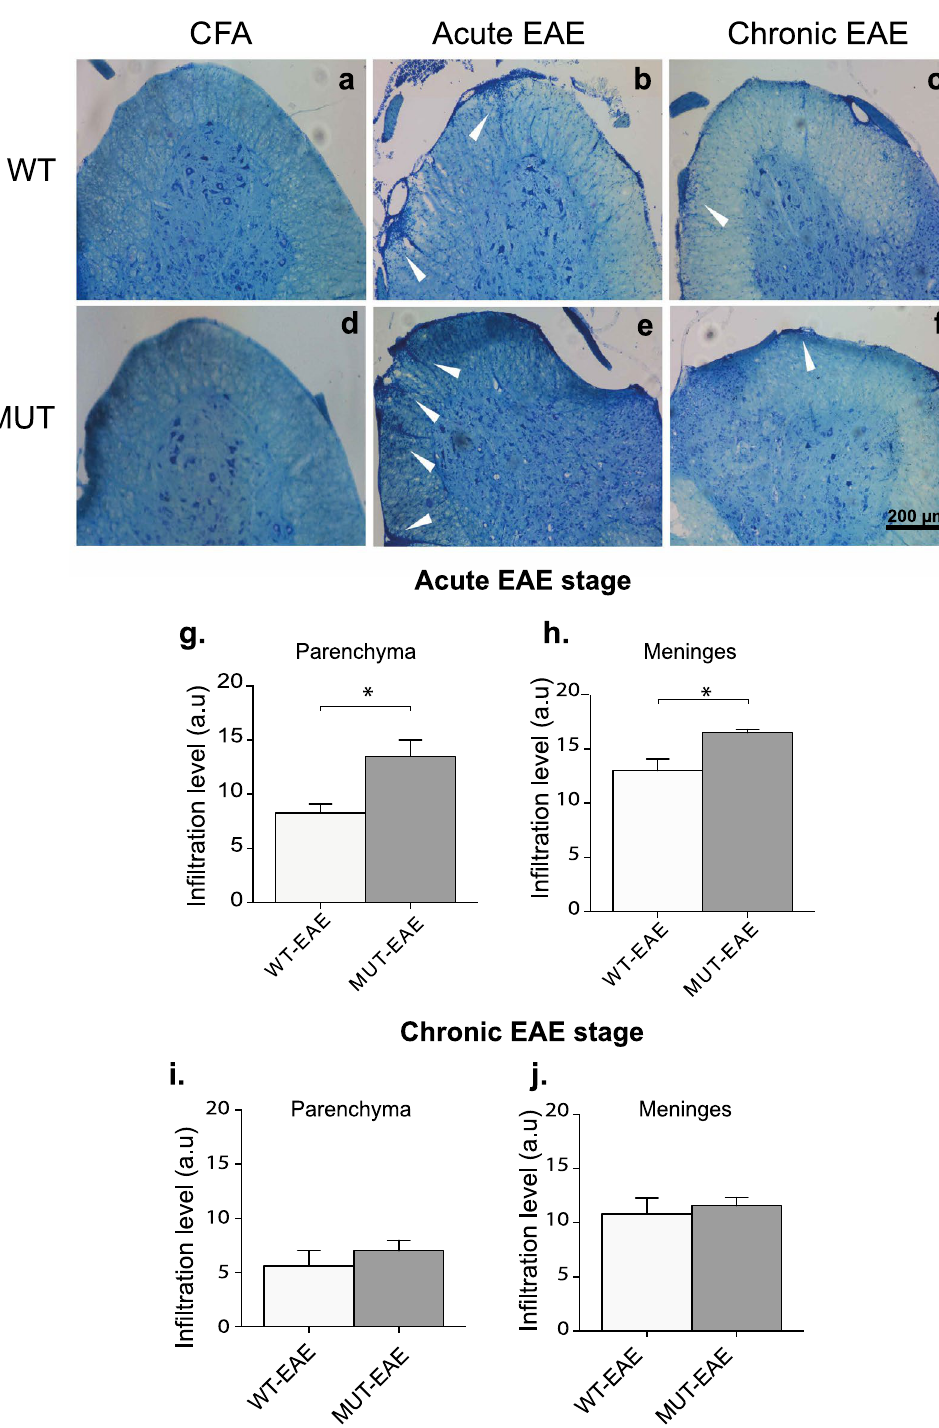
Figure 6. Analysis of infiltrating cells in spinal cord. ( a – f ) Cryosections of lumbar spinal cord were stained with Toluidine Blue and analyzed to determine the level of cellular infiltrates. Representative photos of coronal sections of spinal cords obtained from WT and MUT control animals (CFA) showed no cellular infiltrates ( a,d ). Representative spinal cord images from EAE mice showed typical cellular infiltrates (white arrows) in WT and MUT mice at acute ( b,e ) and chronic stages ( c,f ). Scale Bar: 200 μm. ( g–j ) The level of cellular infiltration in WT and MUT EAE groups was evaluated in meninges and parenchyma, as follows: 0, no infiltrates; 1, one or two cell focus; 2, more than 2 small focuses or one extensive focus; 3, more than two deep or extensive focus of cells. During acute stage, spinal cord from MUT-EAE animals showed higher level of infiltrates in both ( g ) parenchyma and ( h ) meninges compared to WT-EAE. In chronic EAE phase, the extents of cellular infiltration in both spinal cord compartments were lower respect to the acute phase; however, no significant differences were observed between genotypes at this stage ( i,j ). All values are presented as media ± SEM. Results were analyzed using an unpaired t-Student test. *p < 0.05. WT-EAE n = 5; MUT-EAE n =